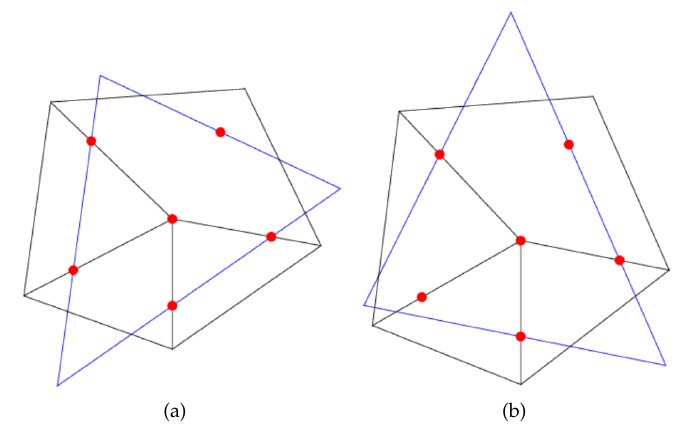
Figure 11. Results produced by the proposed algorithm ( a ) and Dierckx’s algorithm ( b ). Other algorithms for determing PS triangles have also been described in the